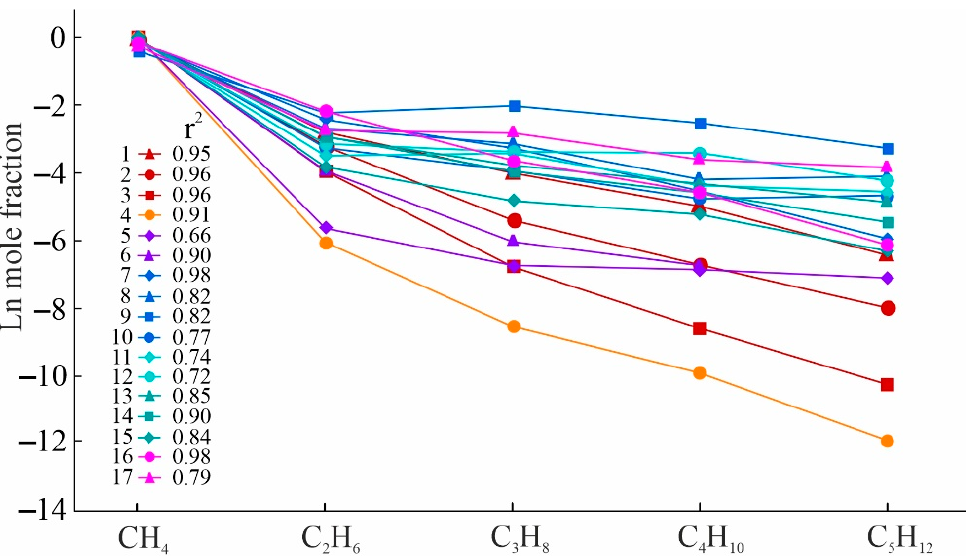
Figure 6. Molecular–weight distributions of hydrocarbons in gases of both geological settings and obtained during experiments. Khibiny massif: (1) Carbonatite complex, (2) foidolites, (3) foyaite; (4) Hakuba Happo hot spring, Japan [40]; (5) mixture of organic and abiogenic gas from the source of the Chimaera Olympic flame, Turkey [75]; (6) mixture of presumably abiogenic (ca. 80%) and organic gas in the Xujiaweizi Fault Depression, Songliao Basin, China [77]. Gas deposits of the (7) North Sea [78]; (8) West Siberia [79]; (9) North Siberia, The Medvezh’e deposit [80]; (10) Caucasus. (11,12) Gas of thermogenic and mixed (thermogenic plus bacterial) origin in the Thrace Basin, Turkey [81]. Oil ‐ type (13), coal ‐ type (14), and mixture (15) in the northern Dongpu Depression, Bohai Bay Basin, China [82]. (16,17) Gas synthesized in a laboratory by Fischer–Tropsch ‐ type reactions at a temperature of 400 ° С [76]. r 2 —coefficient of determination.